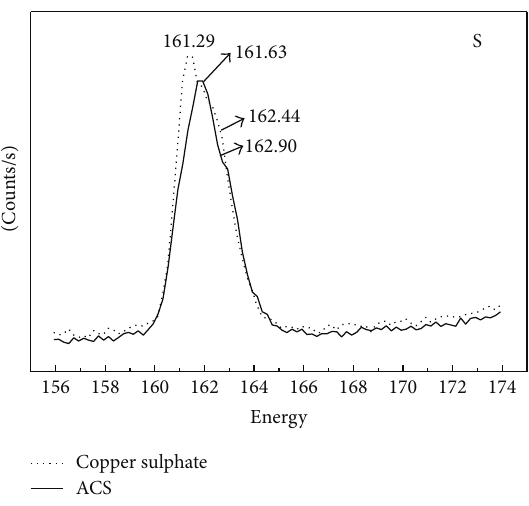
Figure 11: 2p spectra of S on sphalerite in the presence of different activator and collector butyl